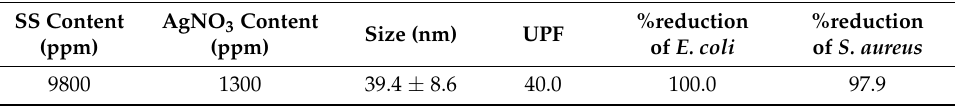
Figure 3. Schematic mechanism of the in situ synthesis of SS ‐ Ag nanocomposite.